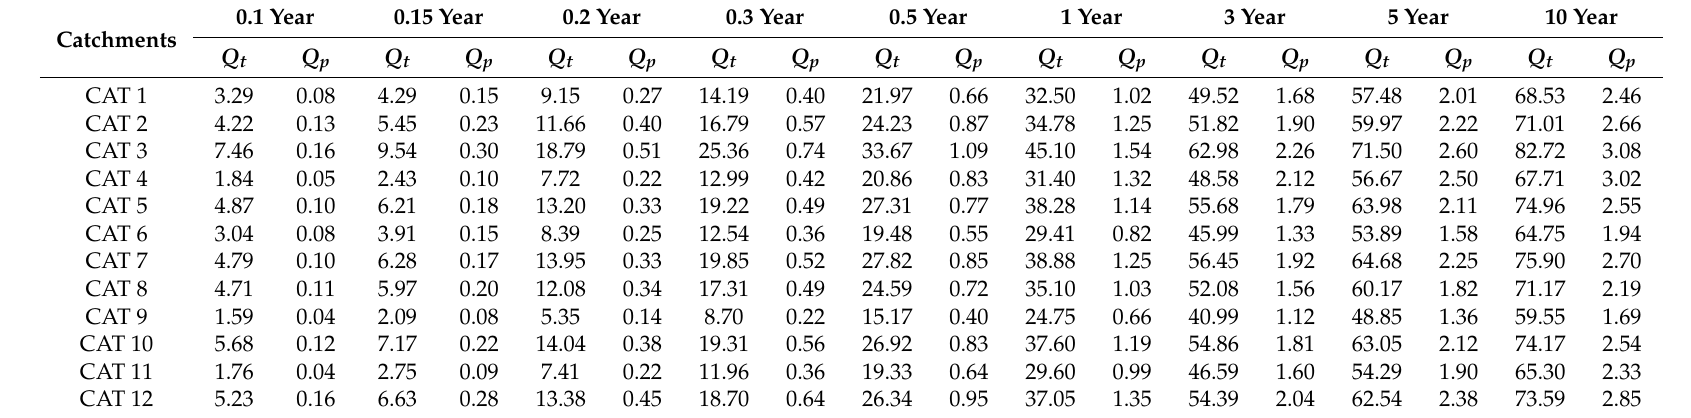
Table 3. Simulated total runoff depth ( Q t , mm) and peak runoff depth ( Q p , mm/min) of the twelve catchments.